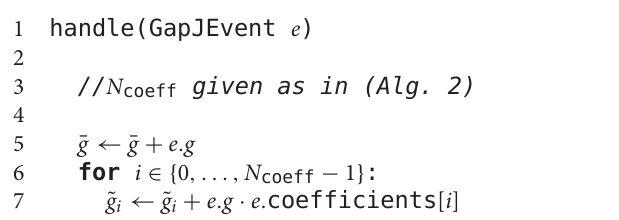
Algorithm 3 | handle function algorithm: The handle function receives the GapJEvents and collects the gap weights and interpolation coefficients according to Equation (6).